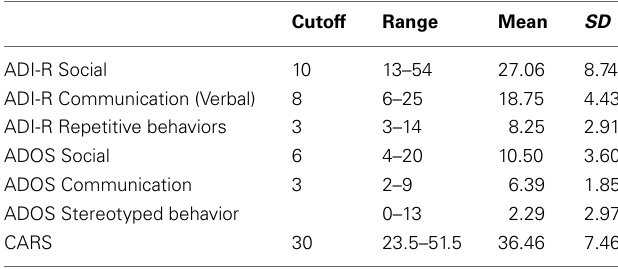
Table 1 | The behavioral